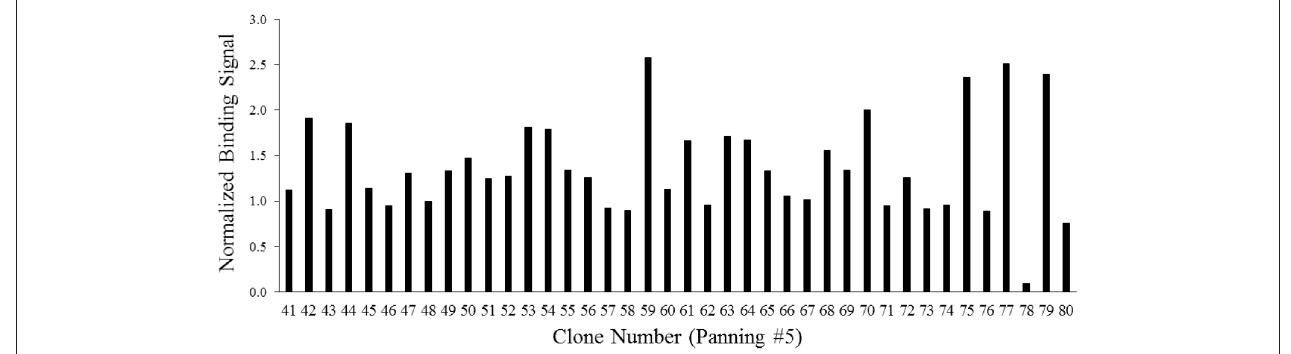
FIGURE 1 | Phage ELISA signals of 40 isolated clones after the fifth panning. PD1-coated wells of a 96-well plate were incubated with amplified phage clones, and phage binding was detected with a monoclonal antibody to M13. Colorimetric signals (absorbance at 450nm) were normalized against signals from wells with no PD1 incubated with the corresponding phage clone. Signals are averages of duplicate wells.